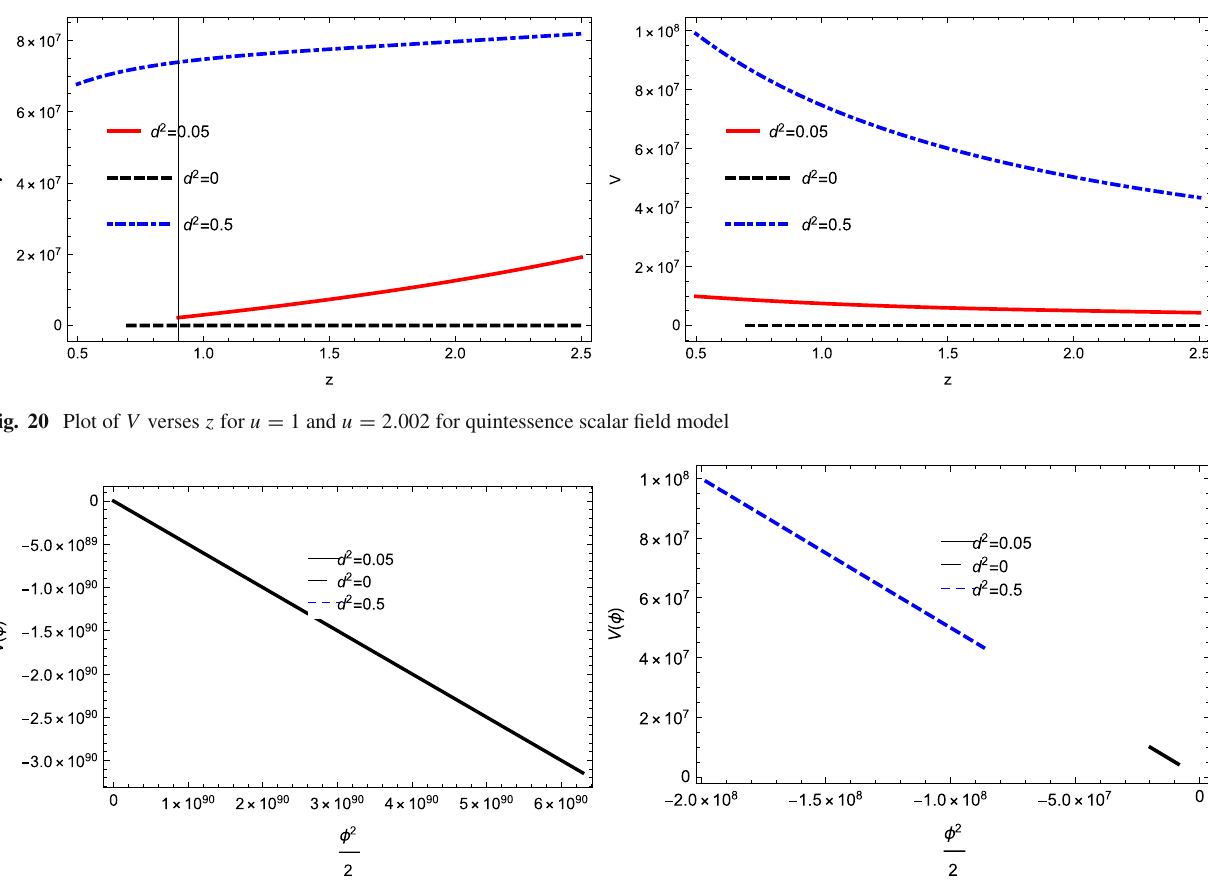
Fig. 19 Plot of φ verses z for u = 1 and u = 2 . 002 for quintessence scalar field model